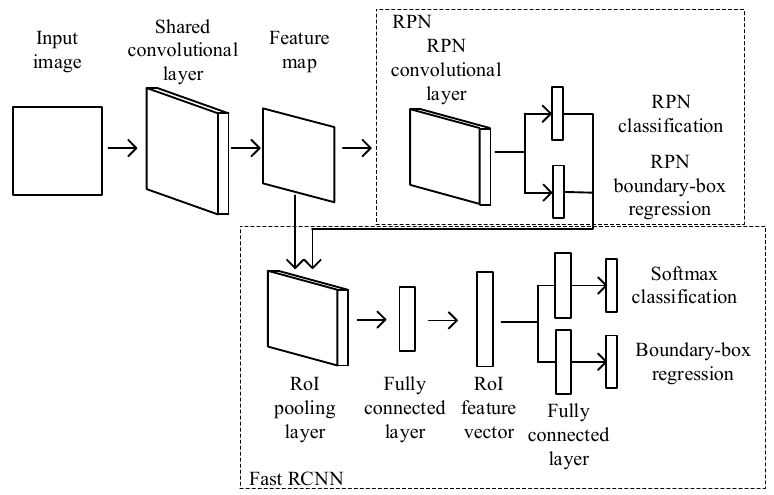
Figure 1. Basic structure of Faster RCNN